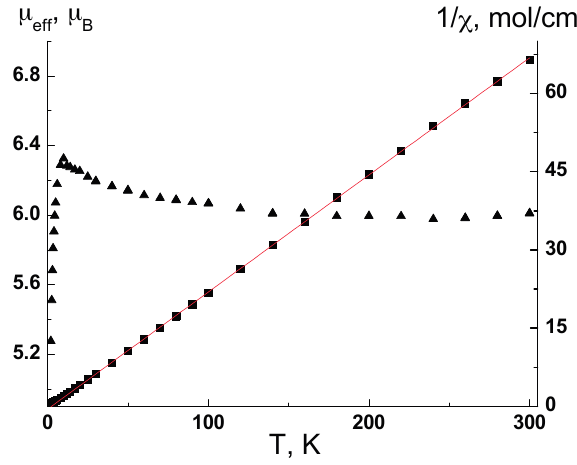
Figure 6. Temperature dependences of µ eff and 1/ χ for [Ni 3 L 1 2 L 2 (Piv) 3 (HPiv) 3